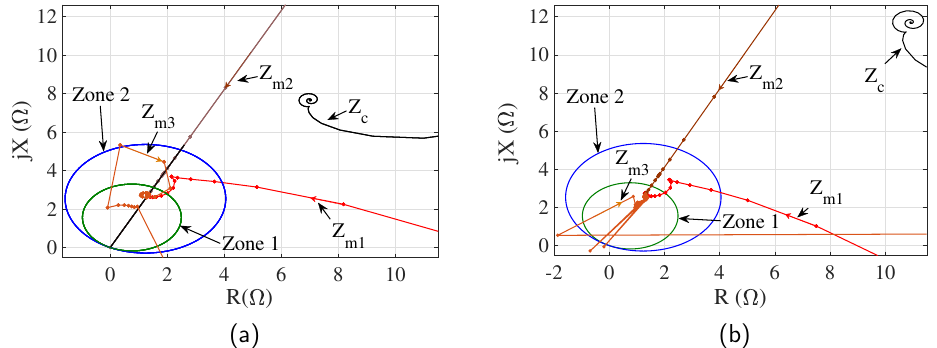
Figure 19. Impedance trajectories of the proposed and conventional methods for ( a ) 3LG and ( b ) SLG faults at 70% of the feeder’s length.